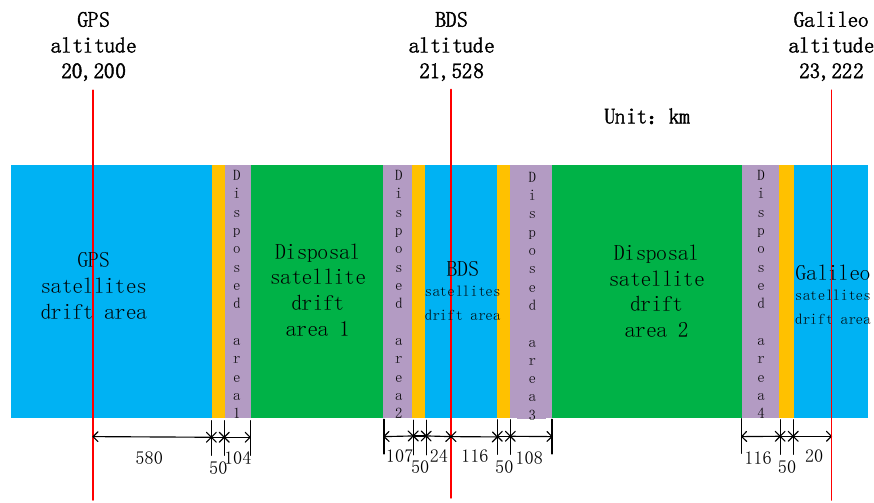
Figure 16. Altitude bounds for disposal region of BDS MEO satellites.